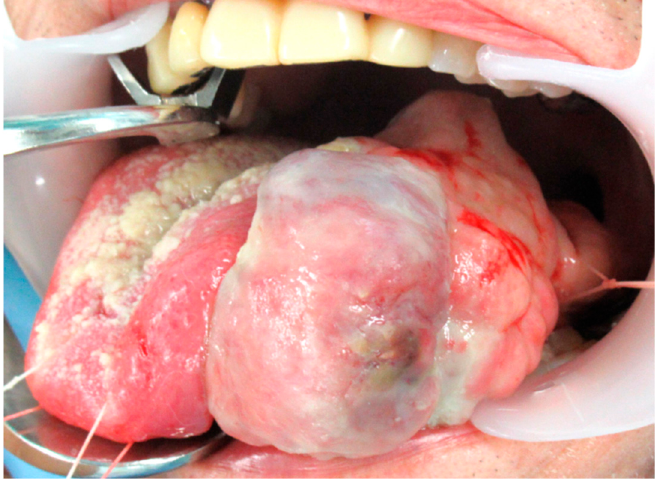
Figure 1. Gross findings of the tumor. The tumor was an exophytic, polypoid mass in the body of the tongue.